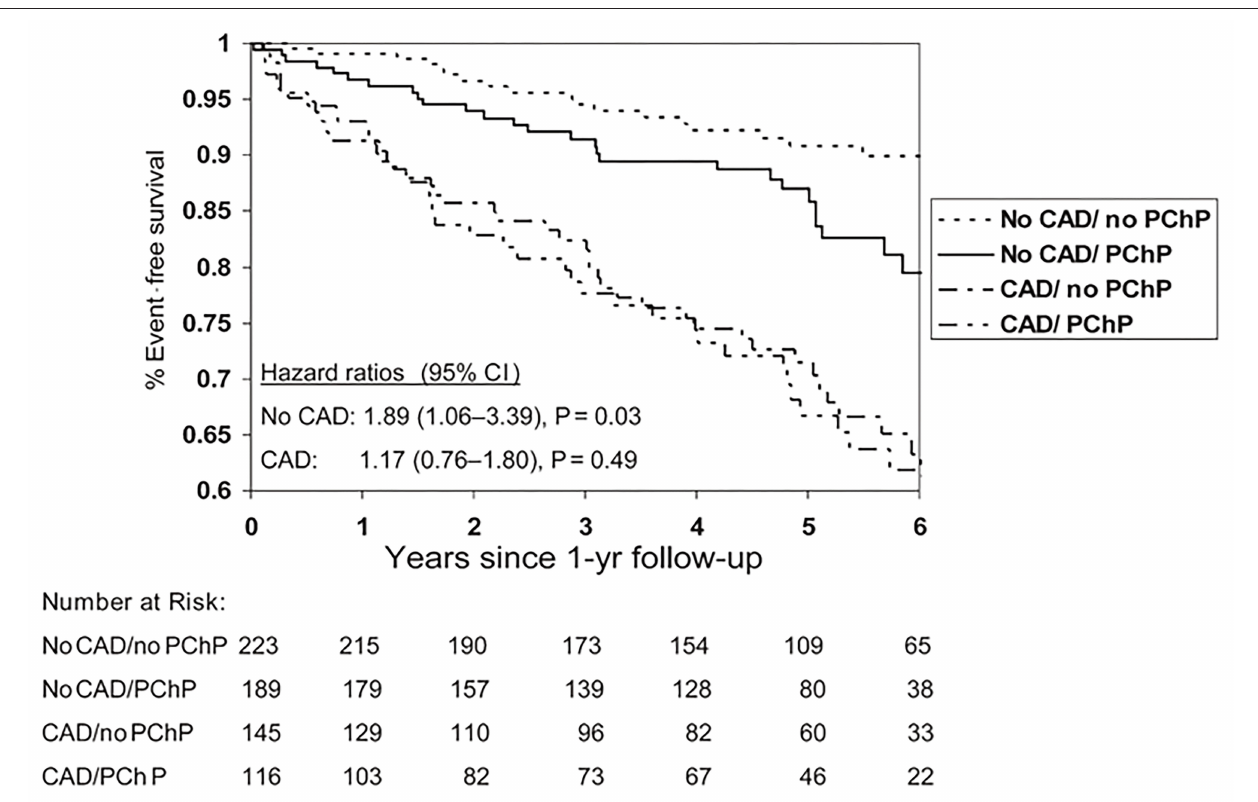
FIGURE 6 | Event-free survival from cardiovascular events by coronary artery disease and persistent chest pain. Cardiovascular events for women with and without persistent chest pain (PChP) in subgroups with and without obstructive CAD. Cardiovascular events defined as cardiovascular death, MI, CHF, or stroke. Reprinted with permission (